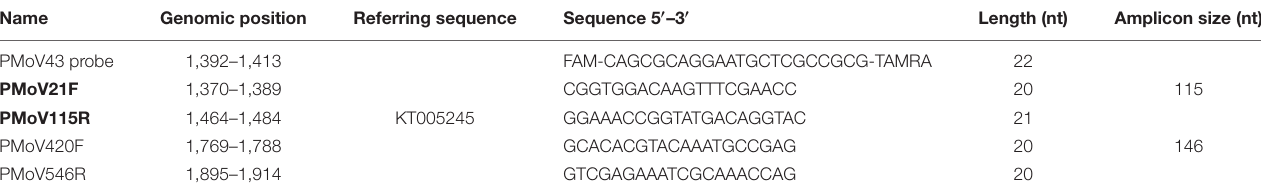
TABLE 1 | Forward, reverse primers and probe designed for RT-qPCR for the detection of